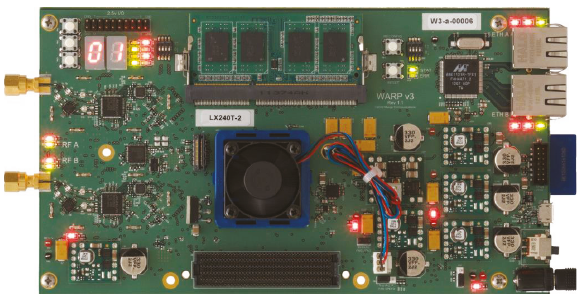
Figure 5: Top view of WARP v3 kit.